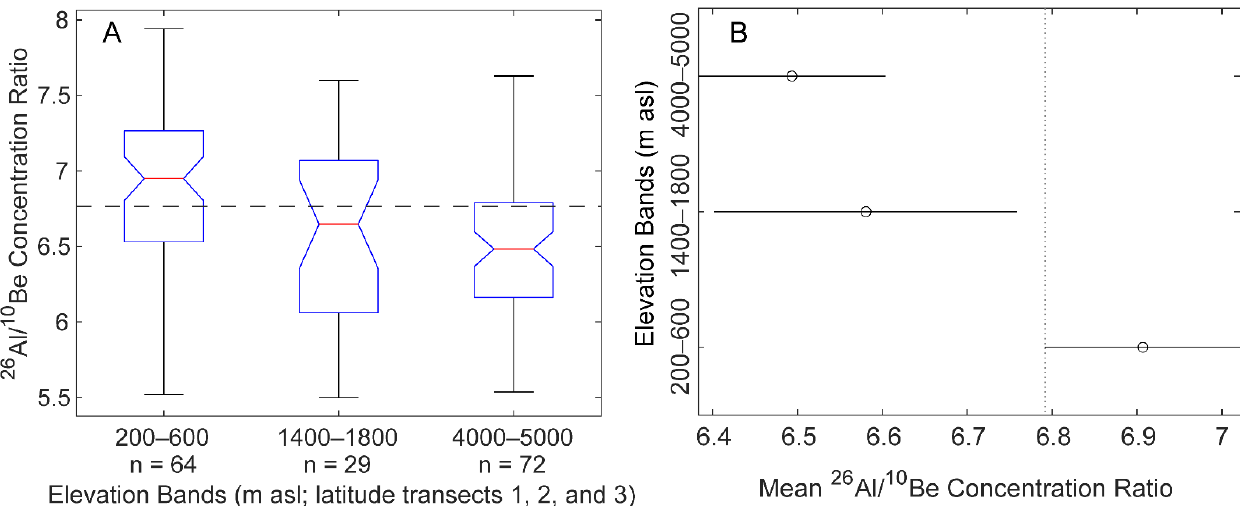
Figure 5. ( A ) Boxplots from ANOVA testing of latitude transects. Each boxplot shows the median (central red line), 25th and 75th percentile values (bottom and top edges of box), and max/min values that are not considered outliers (whiskers). The notches in each box represent median comparison intervals; two boxes with notches that do not overlap have medians that are different at the 5% significance level. For more information see [52]. ( B ) Multiple comparison of means from ANOVA testing. Each circle is the mean 26 Al/ 10 Be concentration ratio from the latitude transects. The line extending horizontally out from this point is the standard error of the mean. Vertical line is superimposed to illustrate the difference between groups.